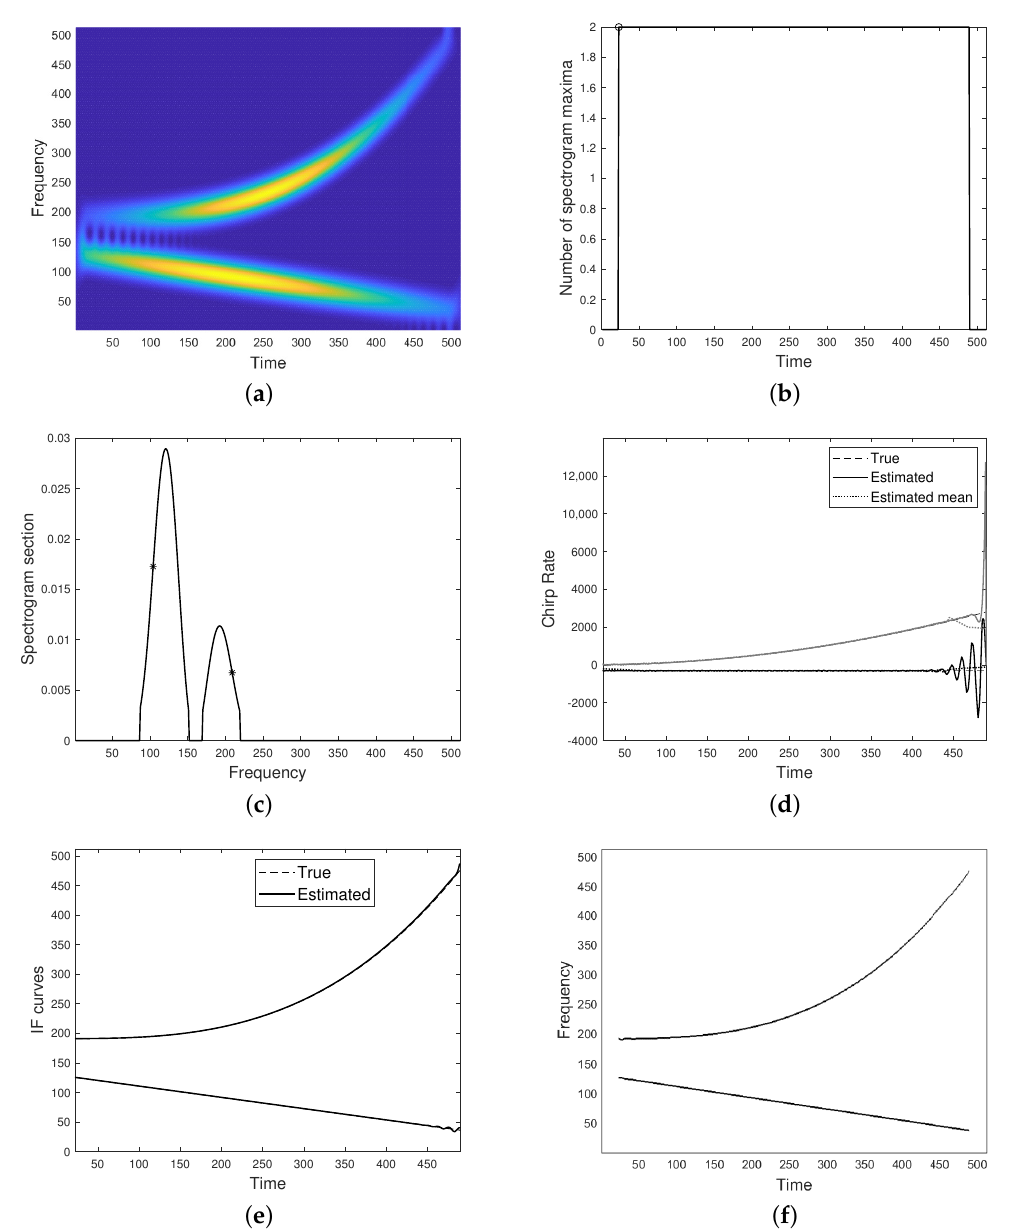
Figure 4. ( a ) Spectrogram of a two-component amplitude and frequency modulated (AM-FM) signal whose modes are well separated, with gaussian amplitudes. ( b ) Number of detected maxima from ( a ) and initial point for integration (round marker). ( c ) Spectrogram section. The star markers indicate spectrogram values at the frequency points ξ 1 , ξ 2 employed for defining the linear system, as in Equation (11). ( d ) Estimated chirp rates (solid line) and their local mean (dotted line). ( e ) Estimated IFs. ( f ) Ridge curves estimated from spectrogram